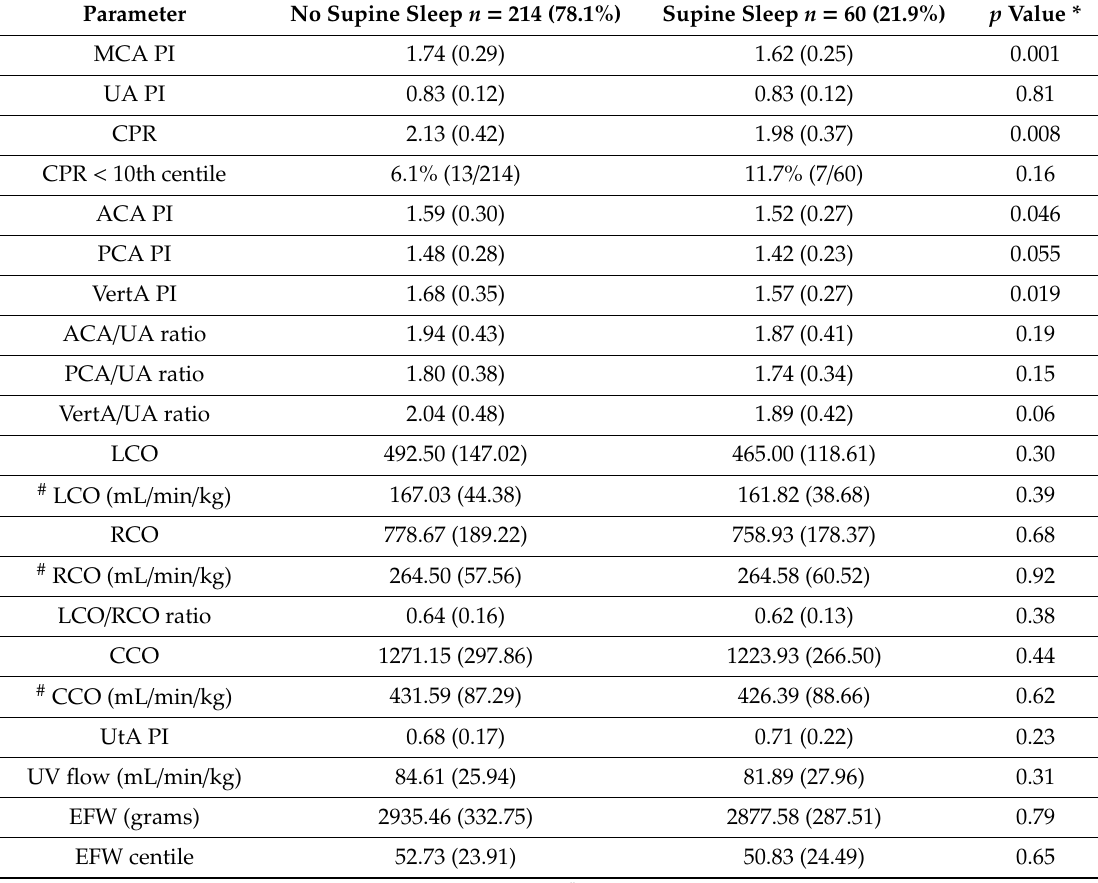
Table 2. Fetal Doppler and cardiac parameters by maternal sleep